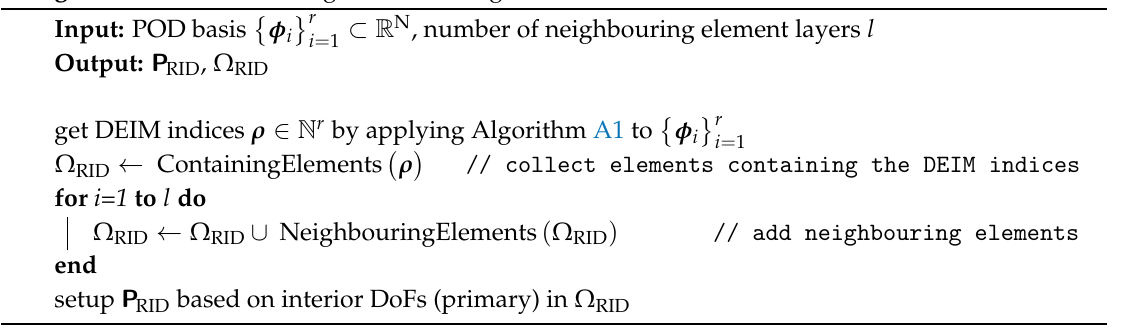
Algorithm A4: Determining Reduced Integration